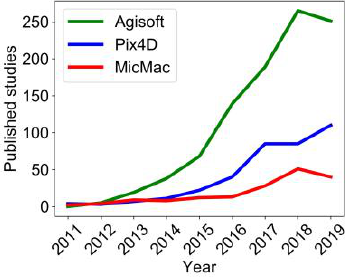
Figure 3: Number of published studies processing UAV imagery with PhotoScan, Pix4D and MicMac in the last eight years, as extracted from Scopus on 28 th November